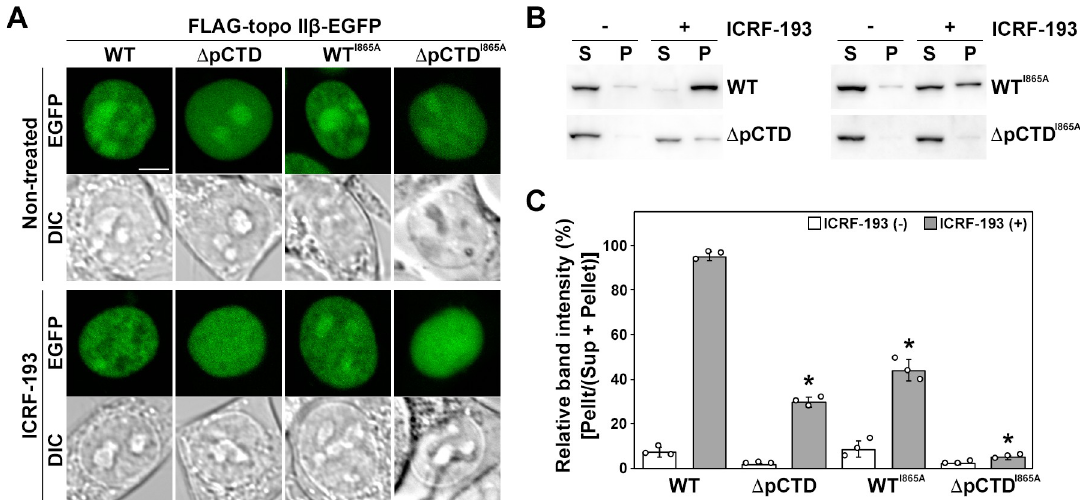
Fig 6. Formation of salt-stable closed-clamp intermediates induced by ICRF-193 treatment. (A) HEK293 cells in a 35-mm glass- bottom dish were transfected with the FLAG-topo II β -EGFP expression vector. The live cells were imaged using a 40 × objective lens. ICRF-193 (7 μ M) was added for 15 min. Scale bar = 5 μ m. (B) The clamping assay was performed as described in materials and methods. FLAG and EGFP-tagged proteins were detected by using the anti-FLAG tag antibody. (C) Relative band intensities in (B) were calculated from band densitometry using Image J software. The experiments were performed in triplicate, and the results are indicated as mean ± S.D. Circles represent individual data points. Asterisks (P < 0.001) indicate a significant deviation from WT (Student’s t-